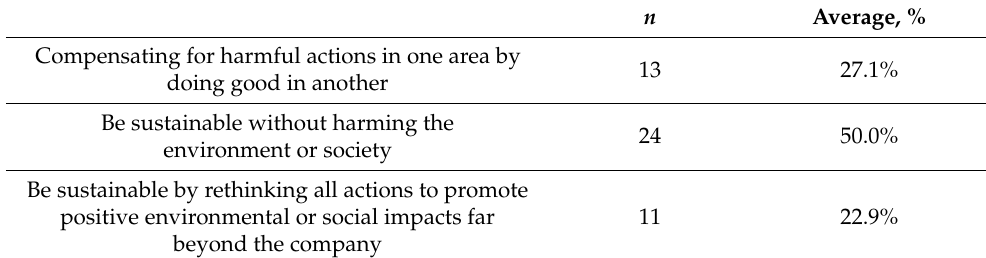
Table 6. Which sustainability strategy does your company use? ( n = 48) (source: authors’ calculation).